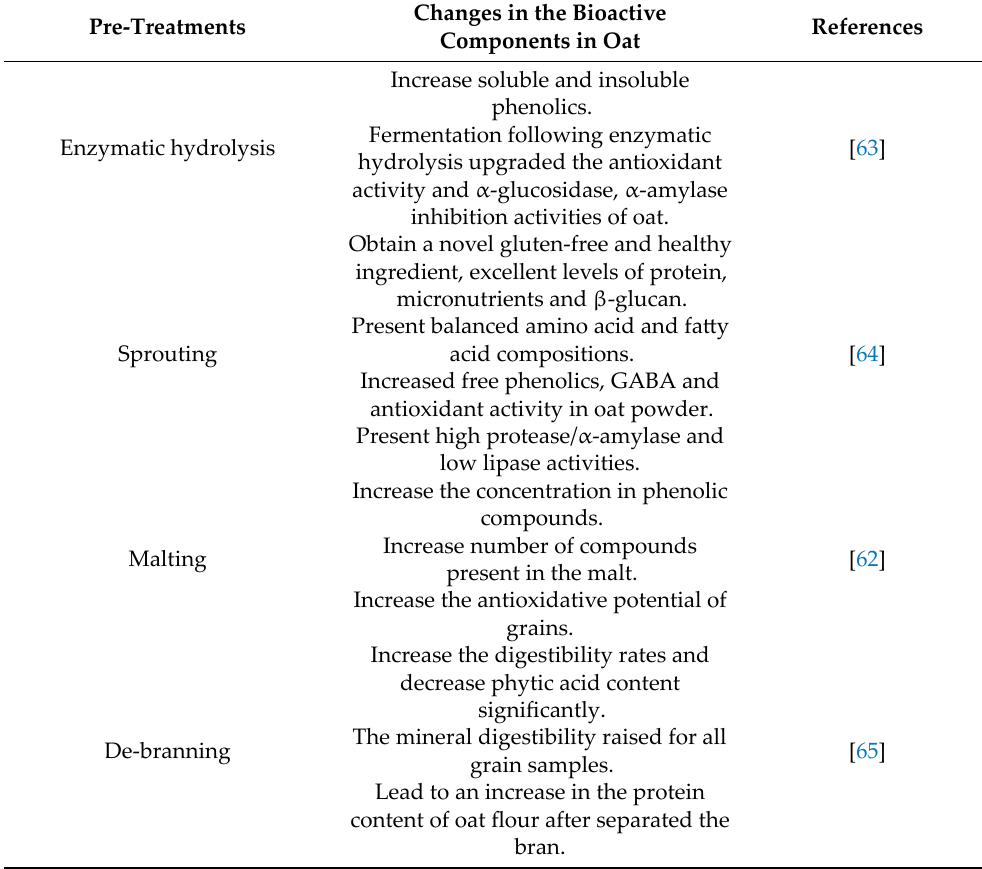
Table 2. Effects of pre‑treatments on the composition of